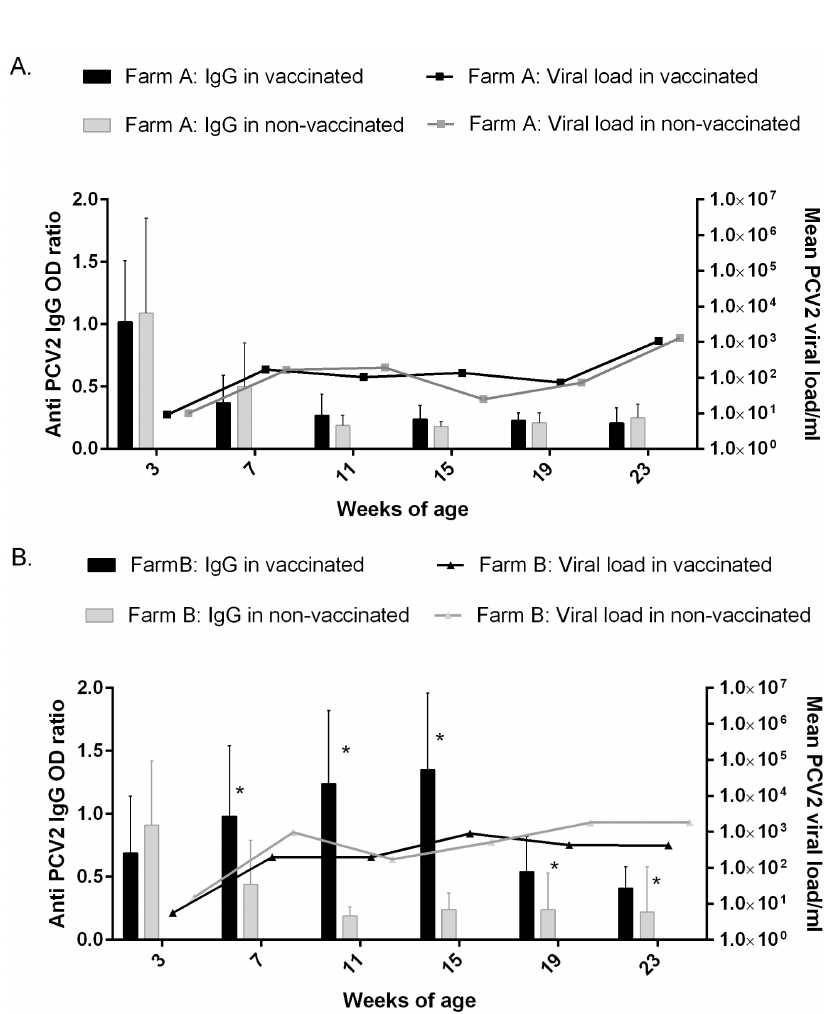
Figure 1. ELISA and PCV2 viral load comparison between vaccinated and non-vaccinated pigs in Farm A (panel A ) and Farm B (panel B ). Bars indicate the mean IgG level in vaccinated (black) and non-vaccinated (grey) pigs at 3, 7, 11, 15, 19, and 23 weeks of age. Lines indicate the mean PCV2 viral load in vaccinated (black) and non-vaccinated (grey) pigs at 3, 7, 11, 15, 19, and 23 weeks of age.